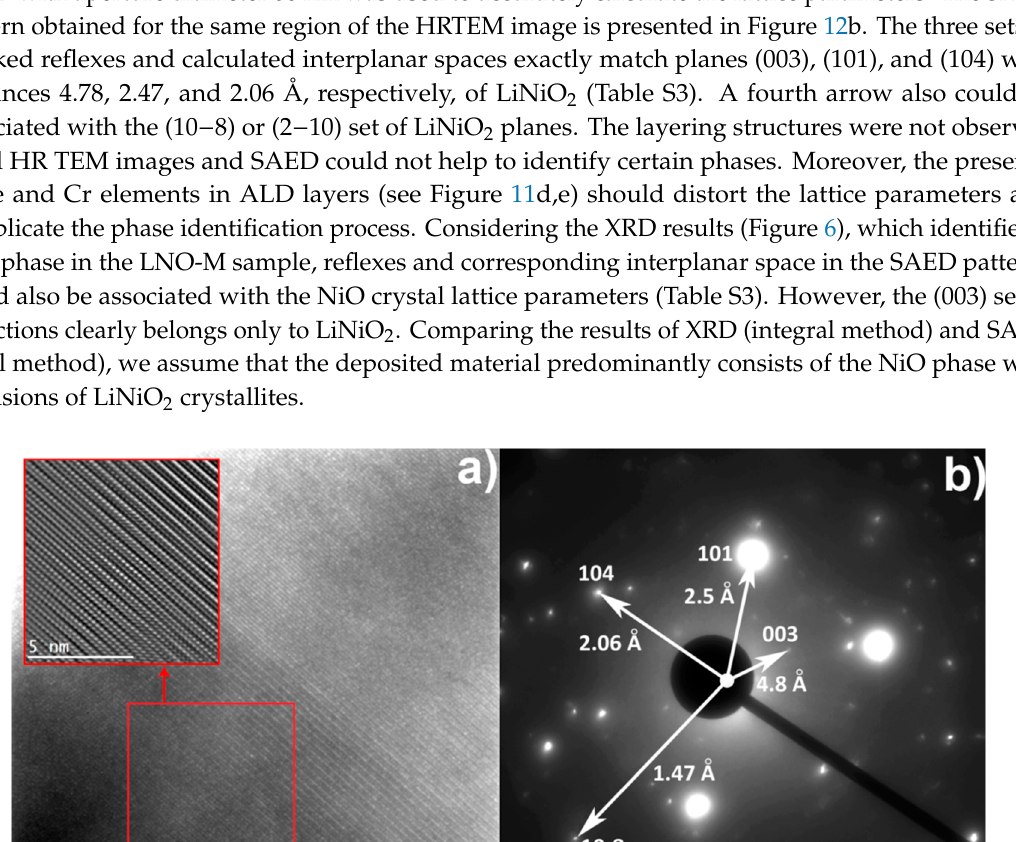
Figure 12. ( a ) High-resolution TEM image of LNO-M-800 sample; inset: results of Fourier filtration of the marked area. ( b ) selected-area electron diffraction (SAED) patterns of the LNO-M-800 sample.